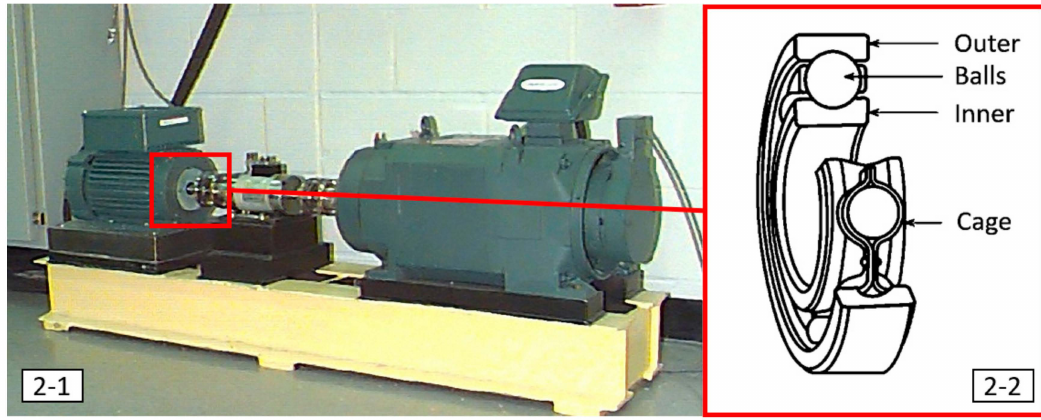
Figure 2. The introduction of experimental platform for the ball-bearing